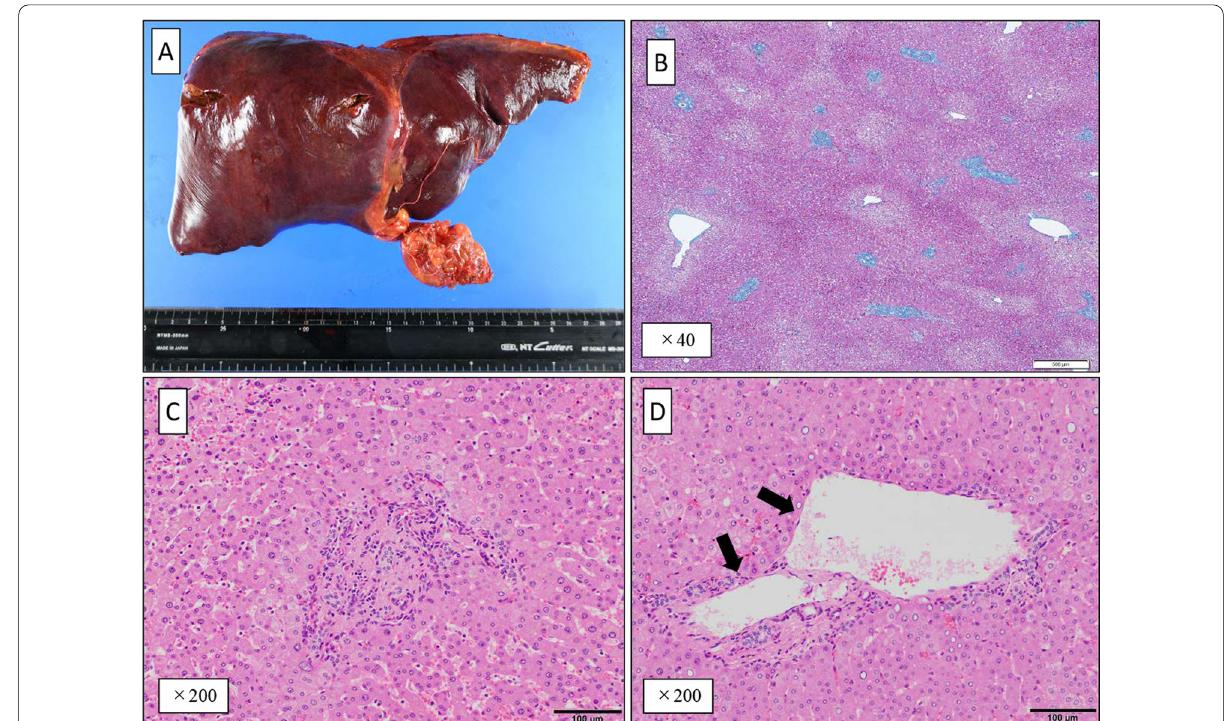
Fig. 2 A Resected specimen. B Pathological diagnosis shows no cirrhosis of the liver, bleeding around hepatic veins, loss of hepatic veins, and no dilation of sinusoids ( 40). C Pathological diagnosis shows loss of peripheral portal vein ( × shunting (arrow)